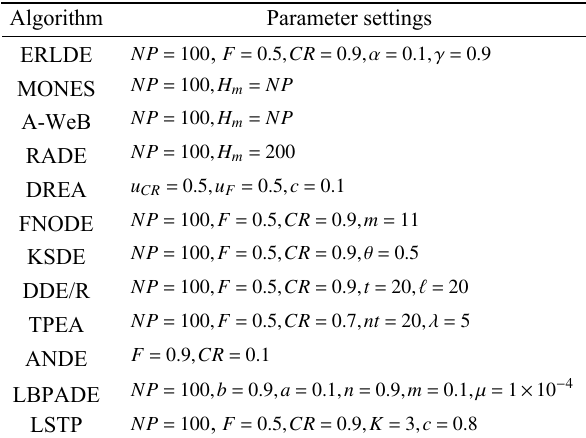
Table 3 Parameter settings for different